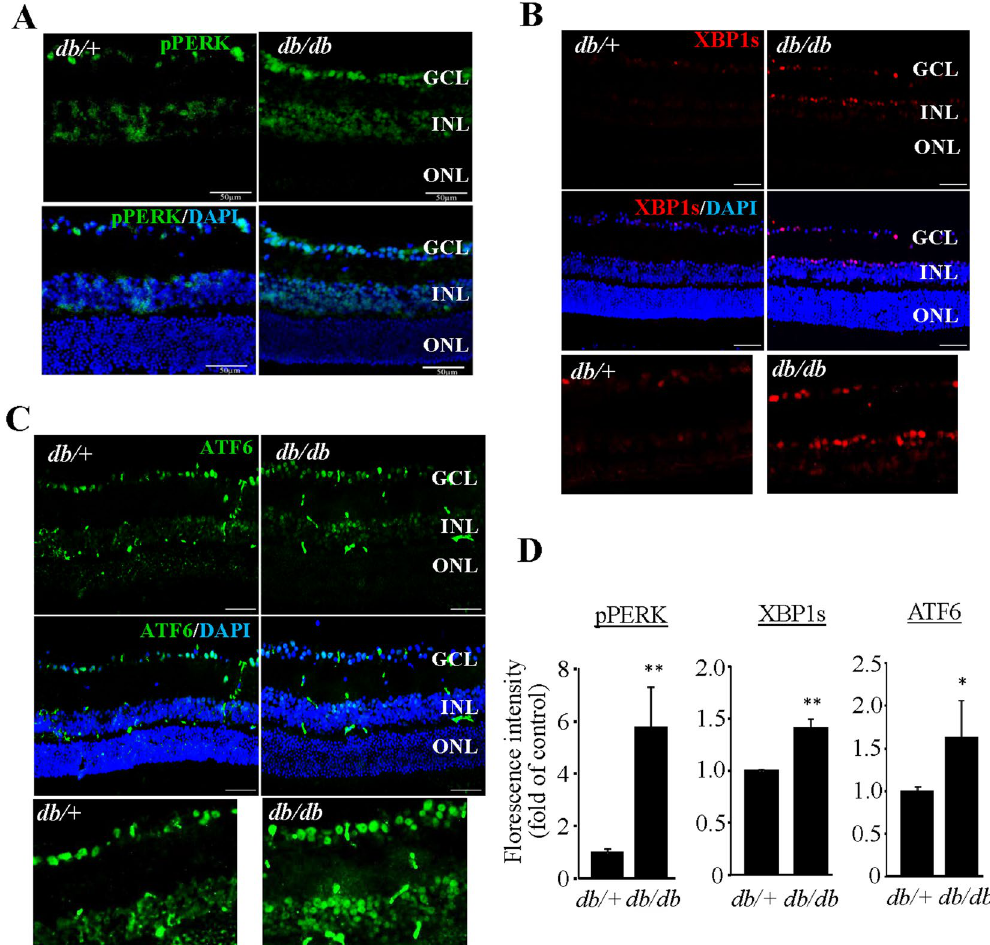
Figure 6. Activation of the UPR and increased level of ER chaperones in the retina of db/db mice. ( A–C ) Immunostaining of retinal sections from db/db mice and db/ + controls of for p-PERK ( A ), XBP1s ( B ), and ATF6 ( C ). Scale bar = 50 μ m for ( A – C ). Images represent results from 3 individual mice in each group. GCL: ganglion cell layer, INL: inner nuclear layer, ONL: outer nuclear layer. ( D ) Fluorescence intensity was quantified by Image J software and expressed as fold of change relative to control (mean ± SD, n = 3). * P < 0.05. ** P < 0.01, Student’s t